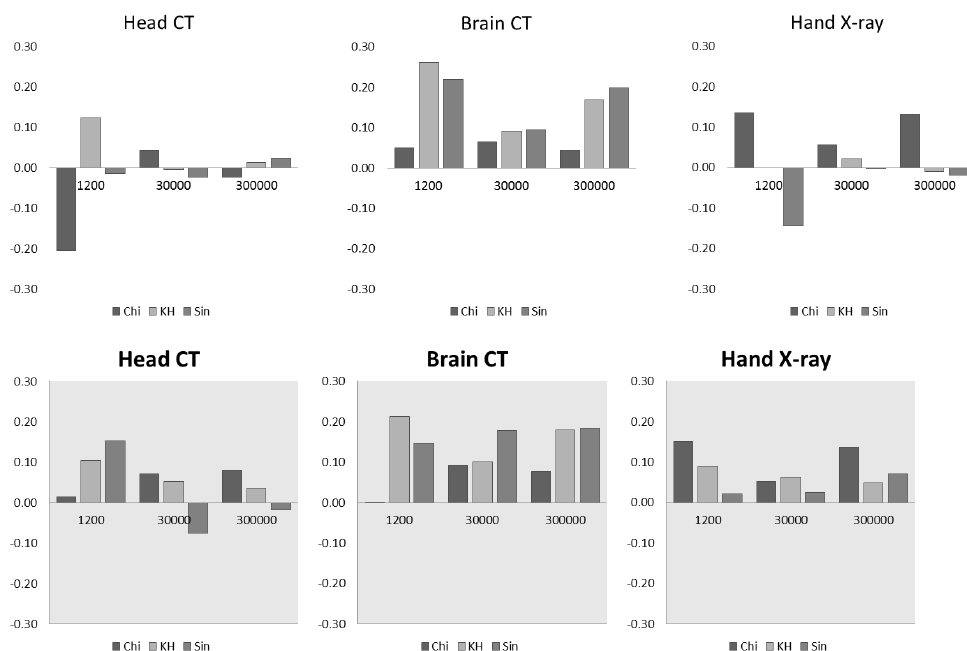
Figure 3. Head CT, Brain CT and Hand X-ray results based on the difference between SACO and ACO standardized values, before (up) and after post-processing with the DeNoise convolutional neural network (DnCNN)